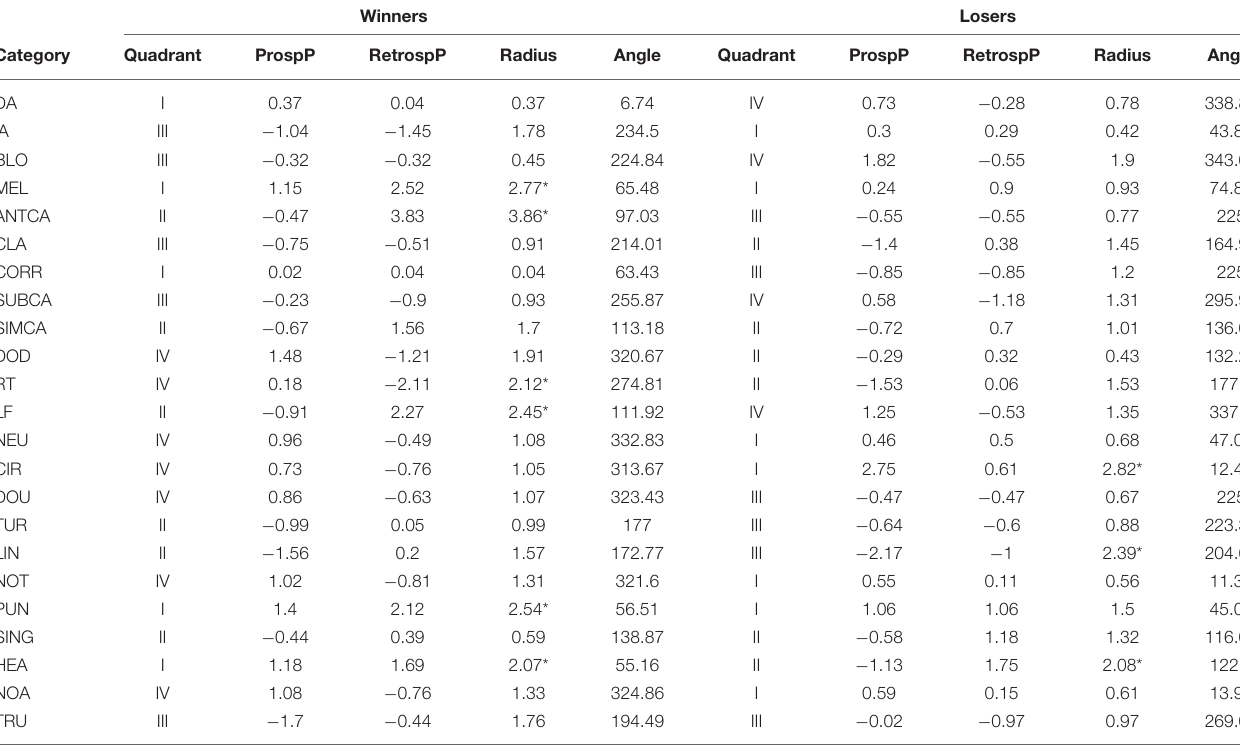
TABLE 7 | Results of the polar coordinate analysis for the 3P focal category in winners and losers. Winners